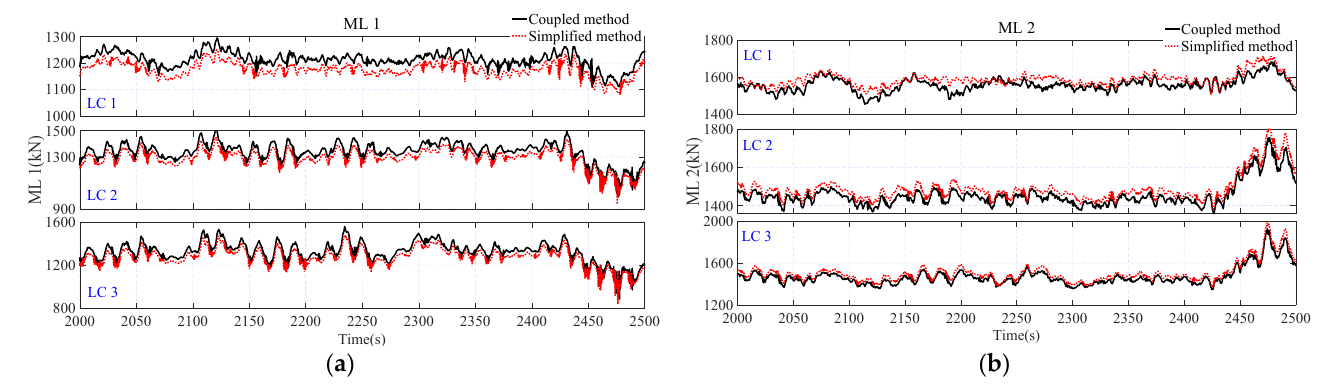
Figure 11. Tower base force of WindFloat SFOWT under different load cases: ( a ) Tower base shear force; ( b ) Tower base bending moment.